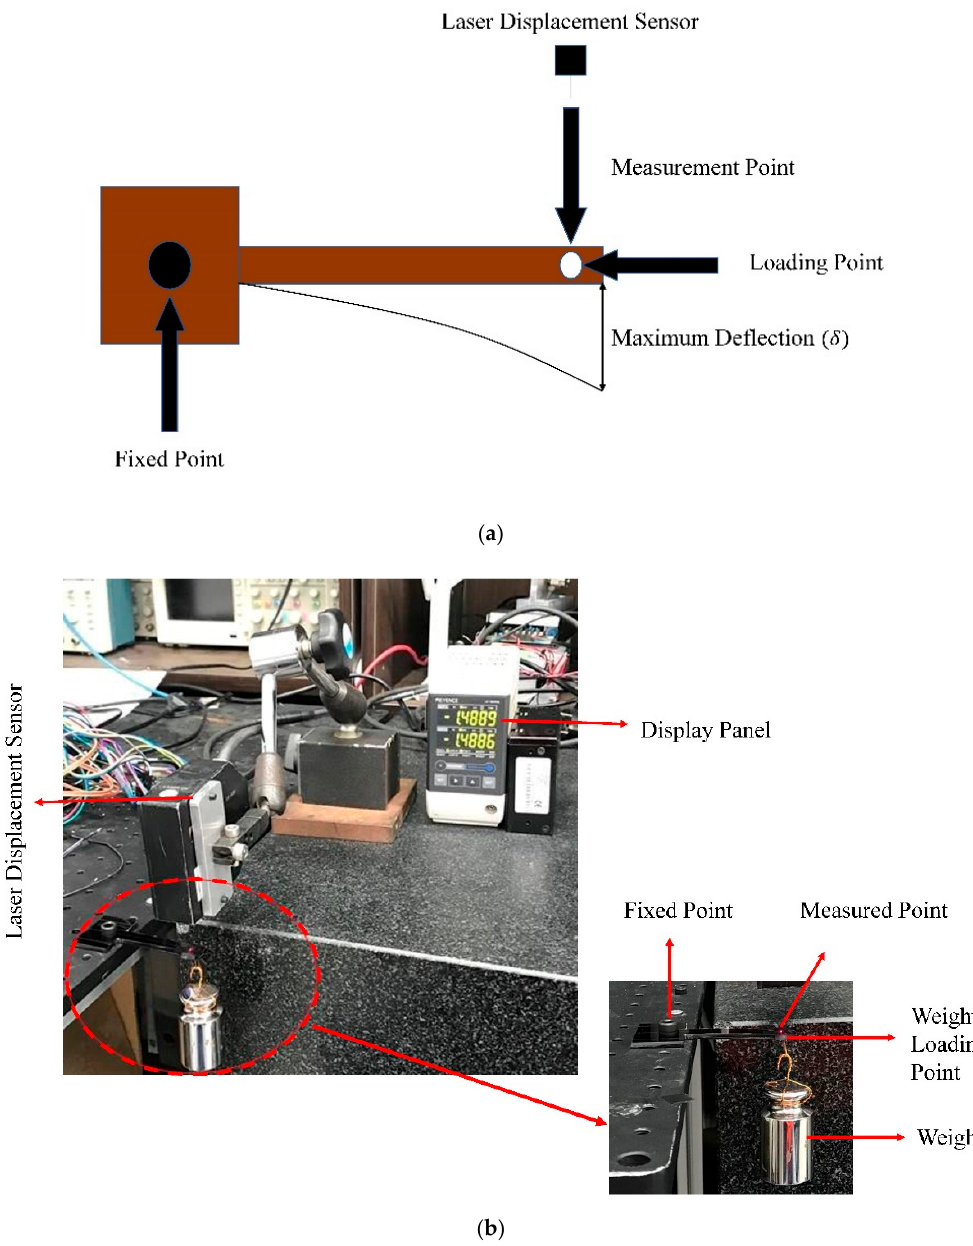
Figure 16. Schematic outlines (a) and experimental setup (b).